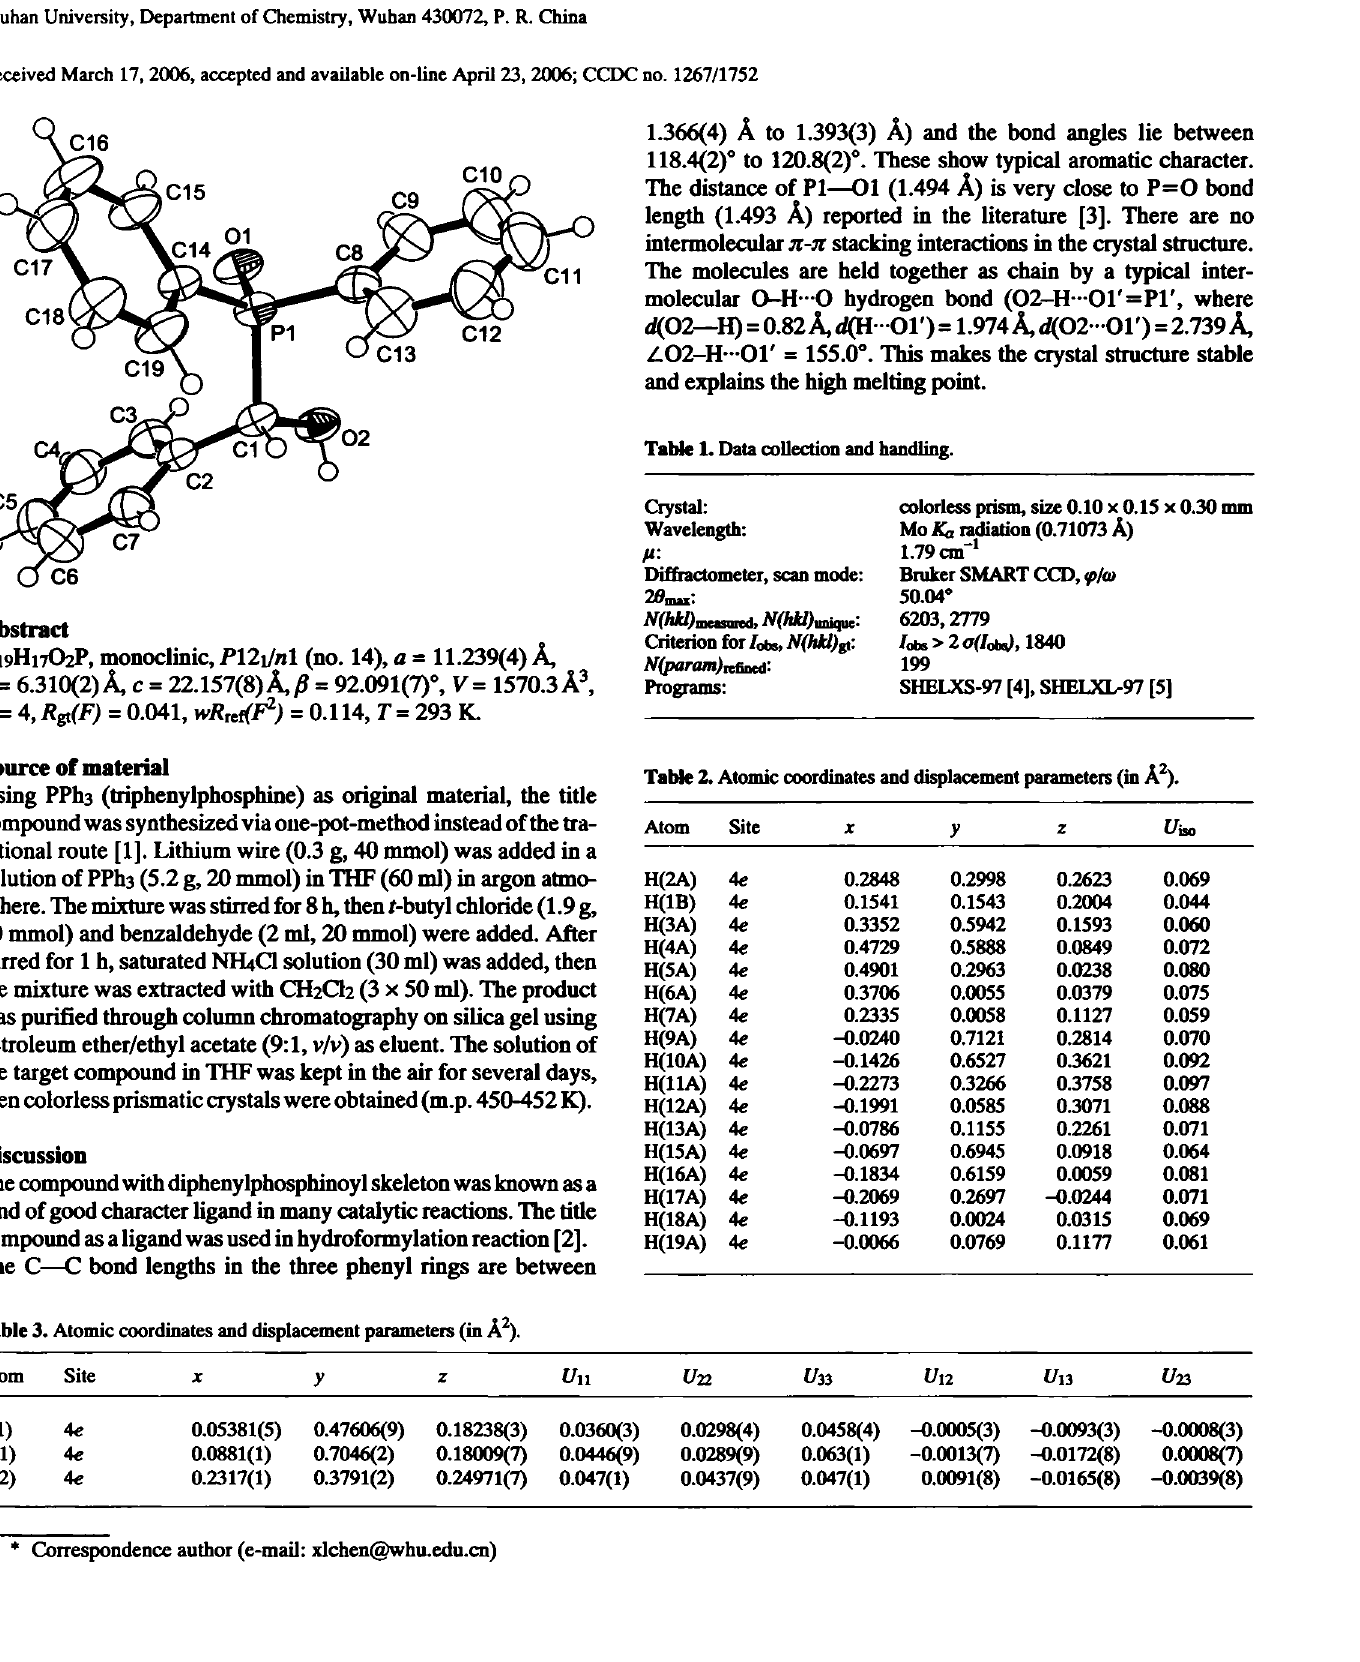
Table 1. Data collection and handling.